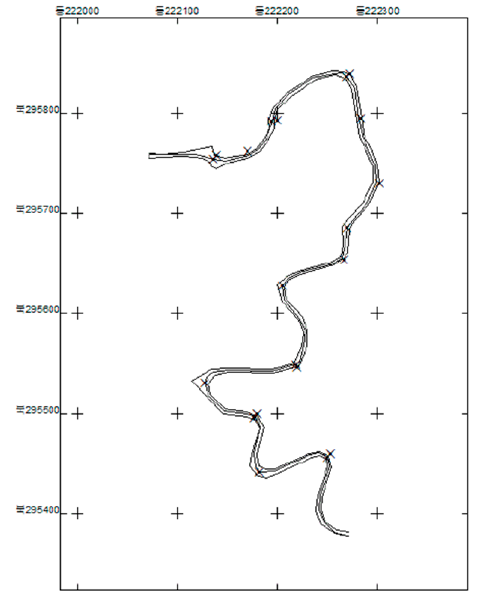
Figure 4. An example of GNSS mapping.